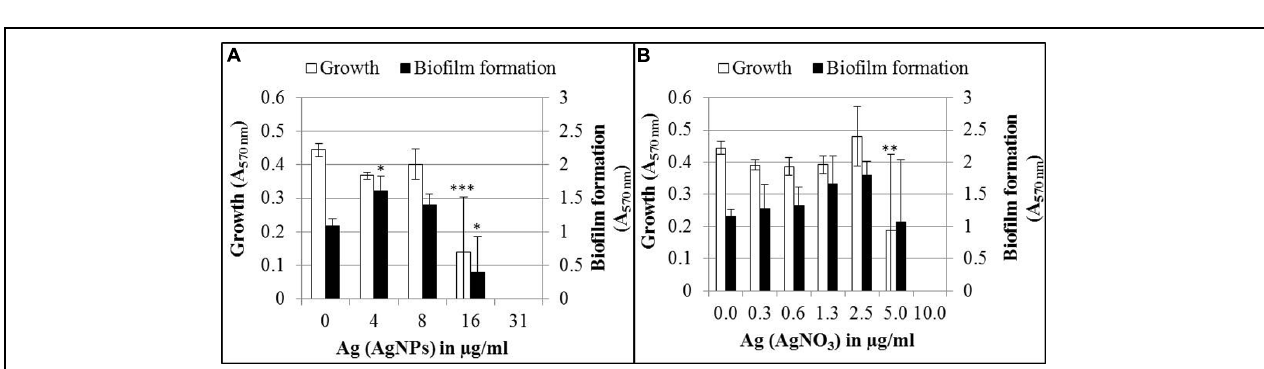
FIGURE 1 | Growth curves of Pseudomonas aeruginosa AdS in LB broth in the presence of different concentrations of AgNPs (A) and AgNO 3 (B). The initial bacterial concentration was approximately 2 × 10 6 cells/ml. n = 3.